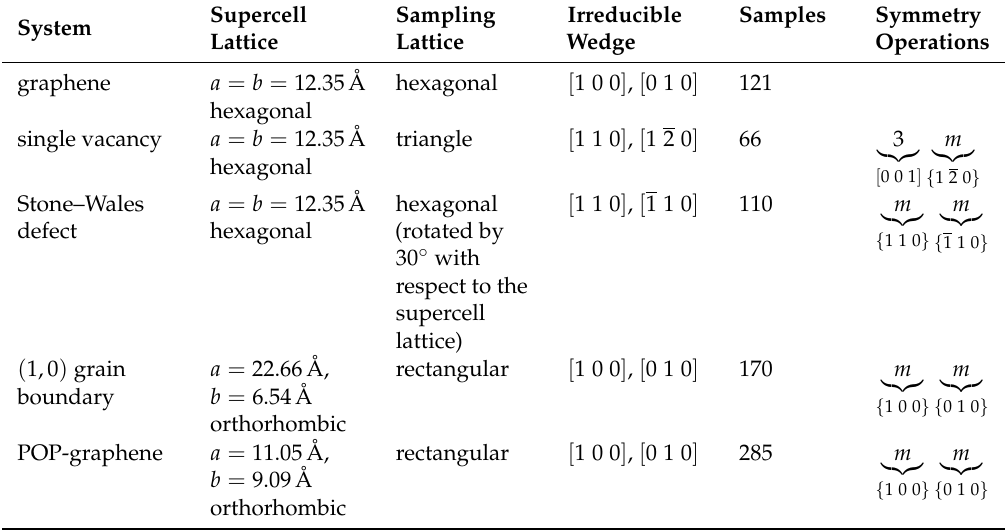
Table 2. Parameters of the sampling used for constructing the adsorption maps. Sampling lattice refers to the symmetry of the sampling lattice, irreducible wedge defines the directions enclosing the sampling area. Symmetry operations refer to how the irreducible wedge is unfolded in order to sample the whole supercell lattice.